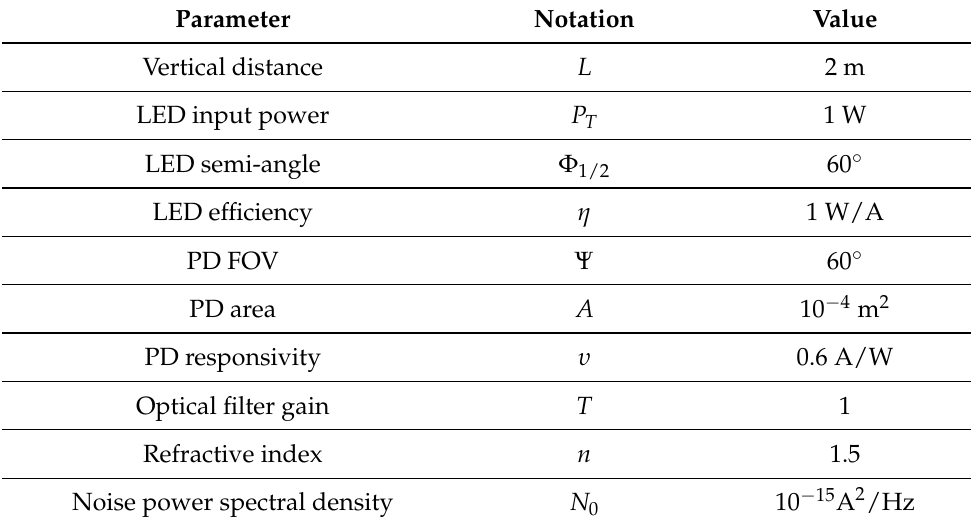
Table 1. Simulation